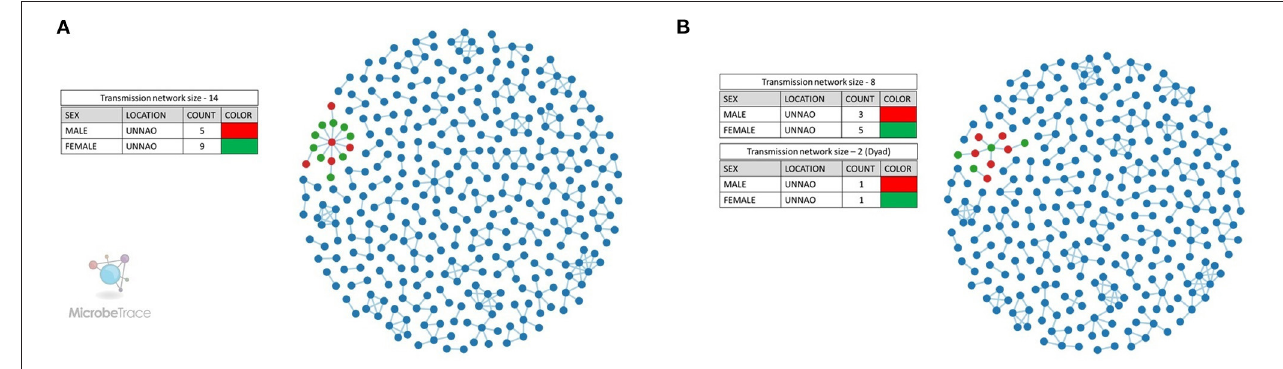
FIGURE 3 | Transmission network visualization by Microbe Trace. (A) Transmission network at a genetic distance threshold of 3%. (B) Transmission network at a genetic distance threshold of 1.5%. Legends represent the colors used for the annotation of node sex for Unnao sequences where red represents the male while green represents the female. The blue-colored nodes represent the sequences from the rest of India.